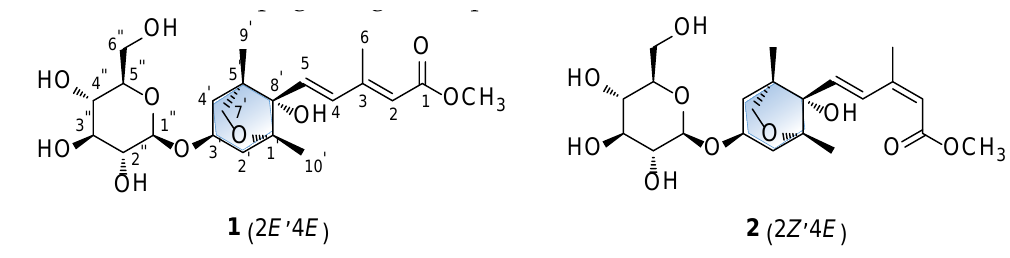
Figure 1. Structures of compound 1 and its geometric isomer 2 .